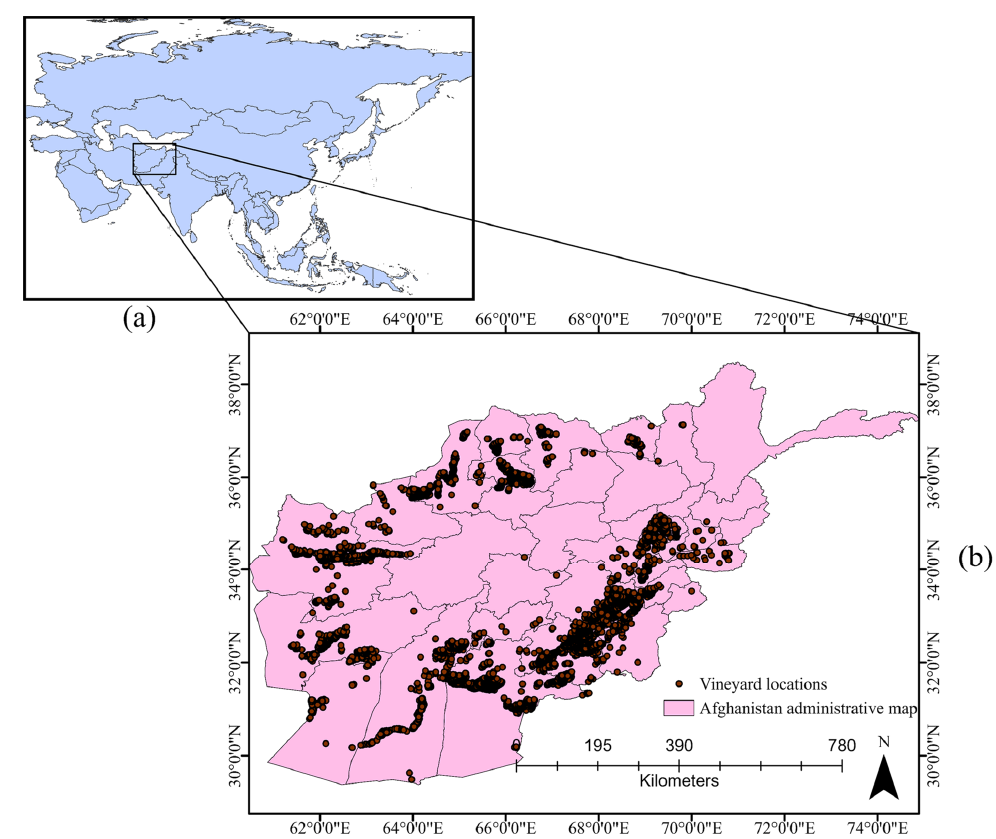
Figure 1. Geographical extent of study area ( a ) Afghanistan on the world map ( b ) Afghanistan administrative map with vineyard location.